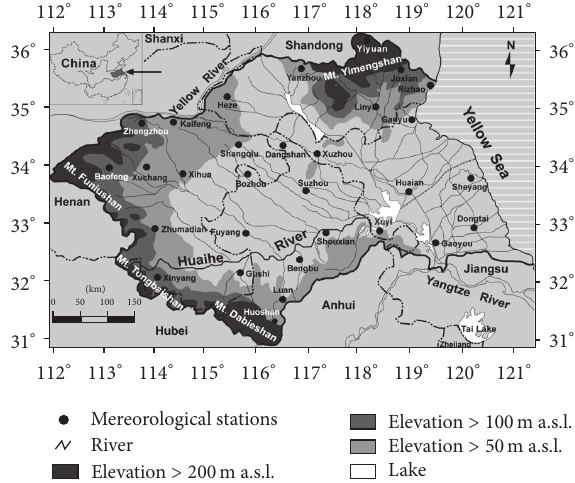
Figure 1: Topographical sketch map of the Huaihe River basin with 30 weather